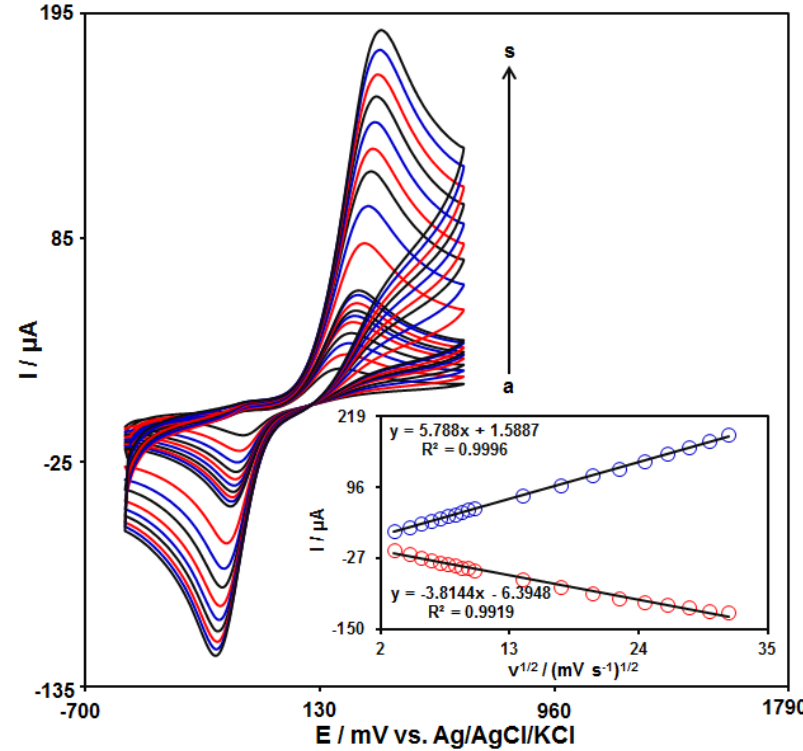
Figure 4. CVs of 150.0 μ M catechol at GO–PAMAM/ILCPE in a 0.1 M PBS (pH 7.0) at varying scan rates (a–s refer to 10, 20, 30, 40, 50, 60, 70, 80, 90, 100, 200, 300, 400, 500, 600, 700, 800, 900, and 1000 mVs − 1 ). Inset: plot of Ipa and Ipc versus ν 1/2 .